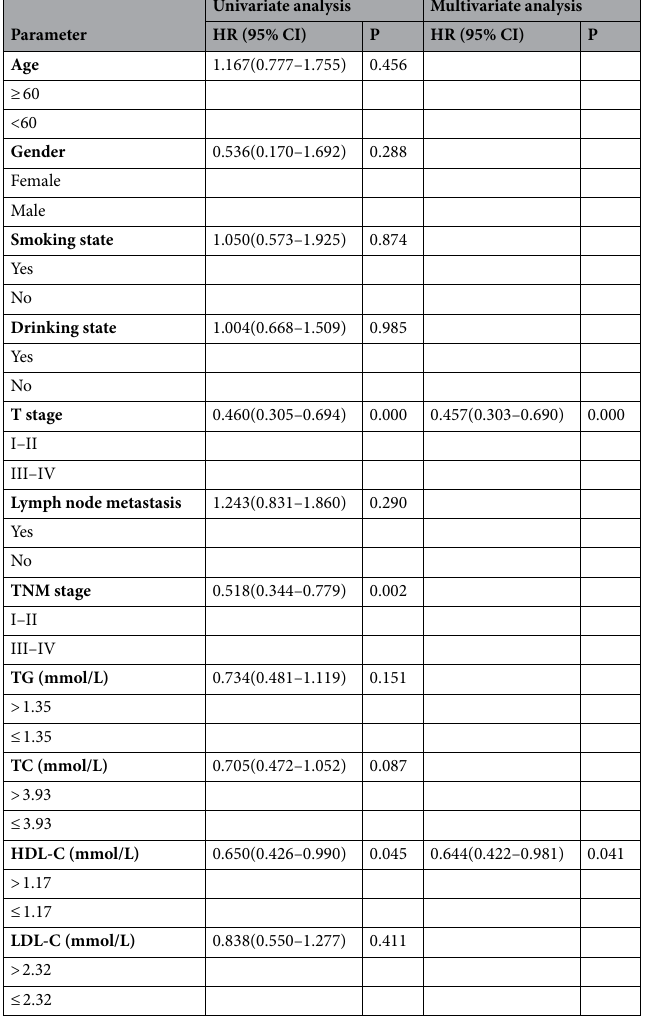
Table 7. Univariate and multivariate cox proportional analysis with disease-free